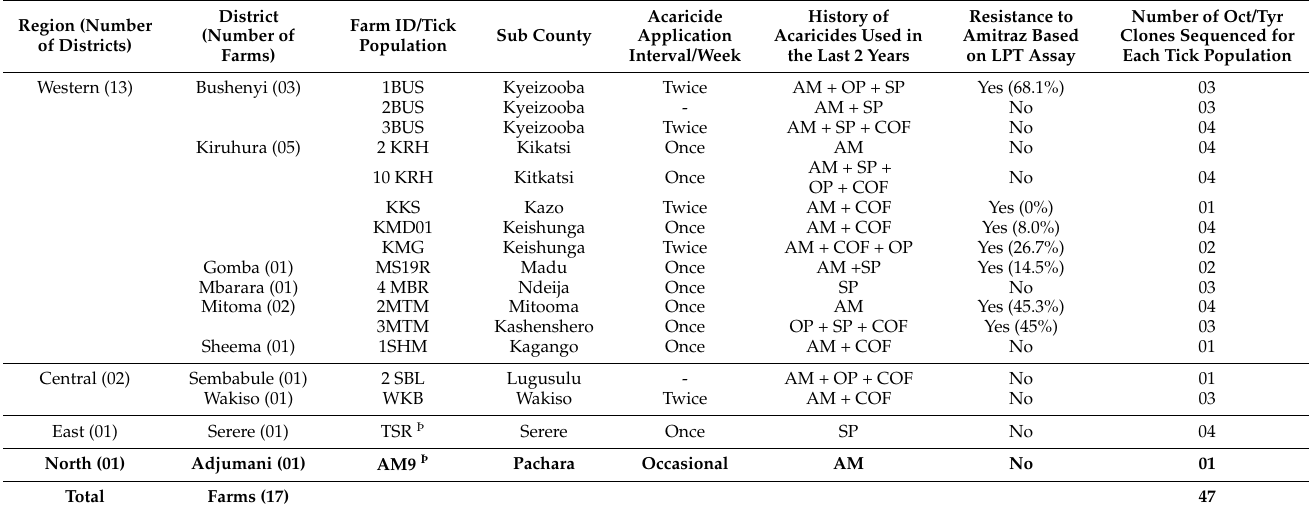
Table 1. Characteristics of the farms from which Rhipicephalus ( B .) decoloratus ticks were collected. Region (Number of